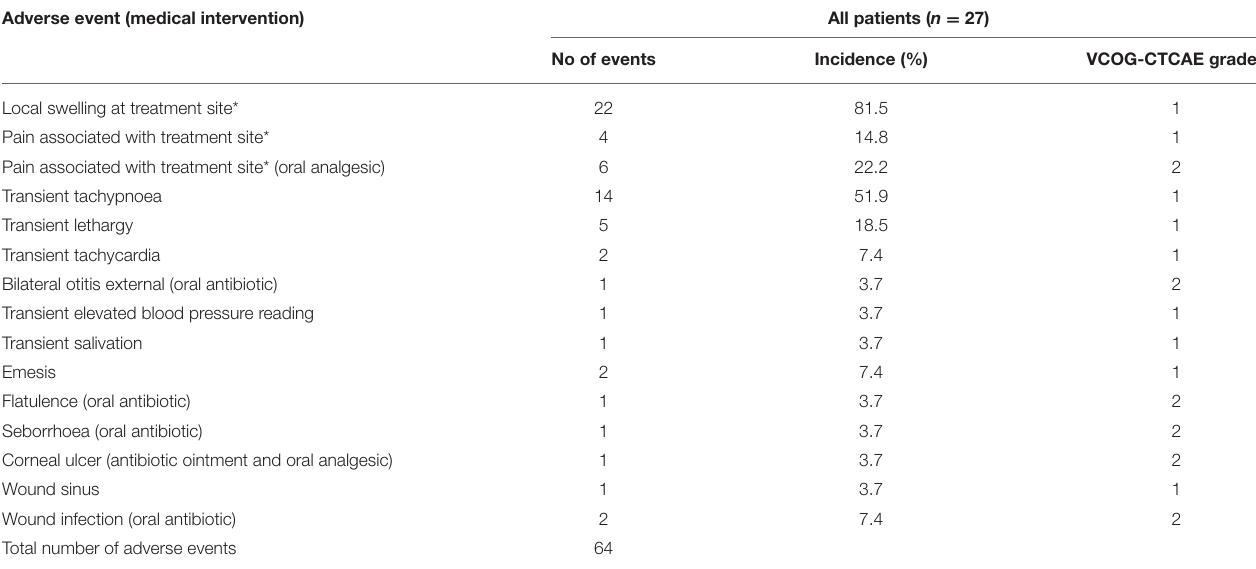
TABLE 6 | Incidence and VCOG-CTCAE grading of adverse events. Adverse event (medical intervention) All patients ( n = 27)